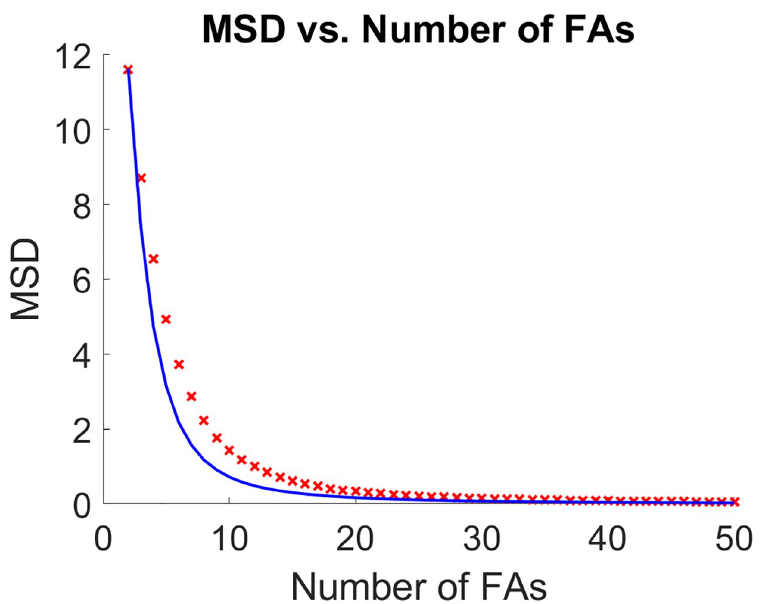
Fig 5. Lower bound for the MSD. Experimental MSD (red x’s) compared against the lower bound for the MSD (blue line) found in Eq (15). For this graph, a trajectory of 10,000 data points was used for the experimental MSD with r = 1.